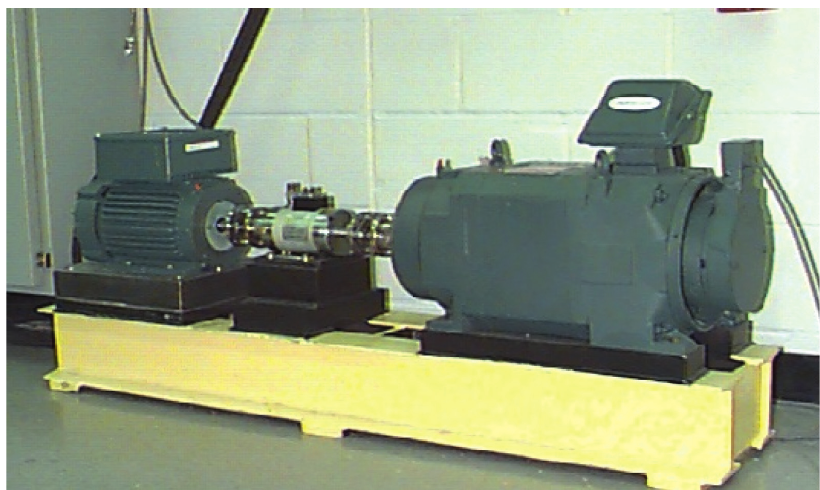
Figure 21: Experimental